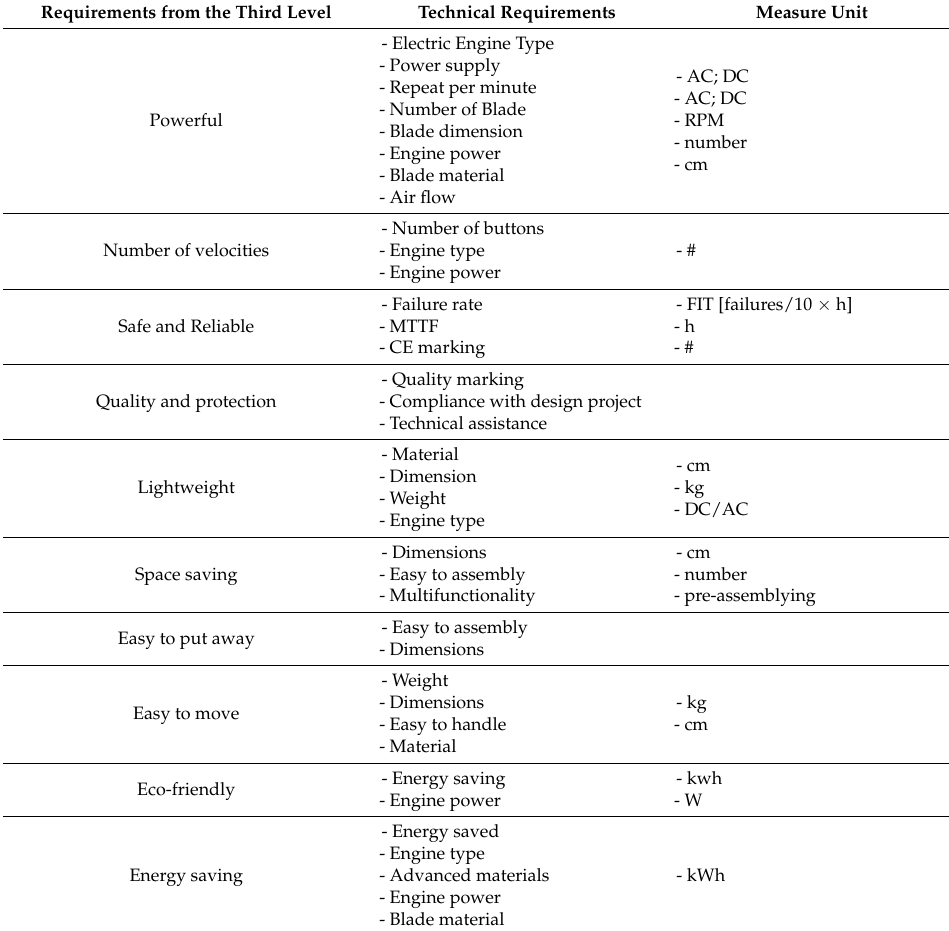
Table 4. Example of technical requirements of the innovative